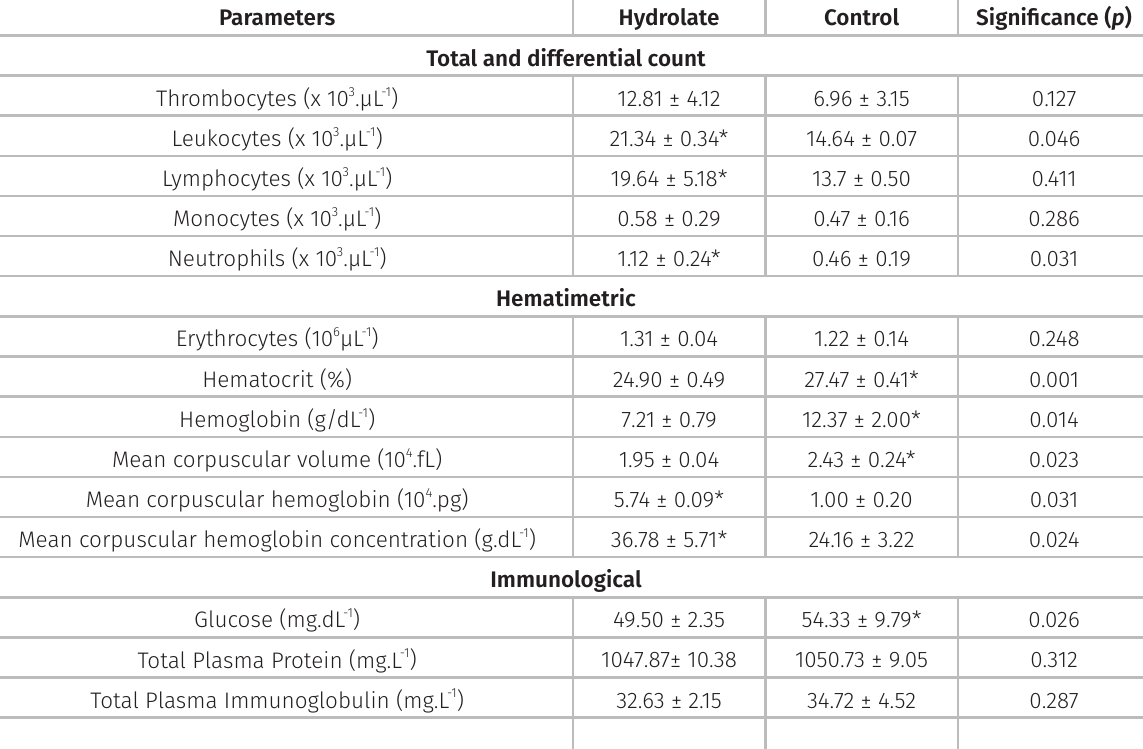
Table IV. Blood profile of Nile tilapia ( Oreochromis niloticus ) fed a supplemented hydrolate diet from Curcuma longa